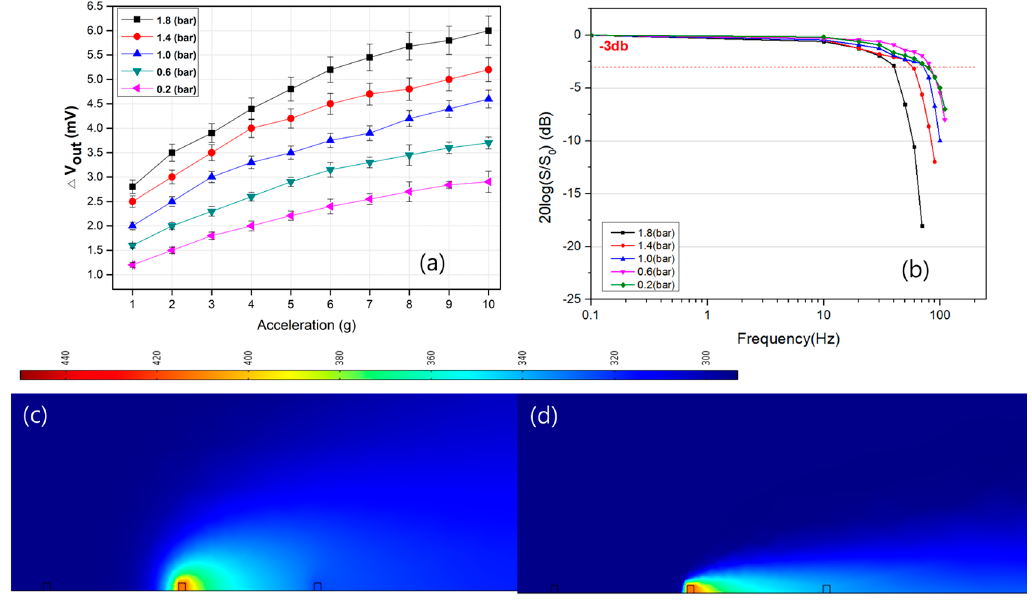
Figure 6. The output characteristics of the accelerometer as a function of pressure with respect to: ( a ) acceleration and ( b ) frequency. Simulation results at gas pressure of ( c ) 1 bar and ( d ) 1.8 bar (heater: 450 K).